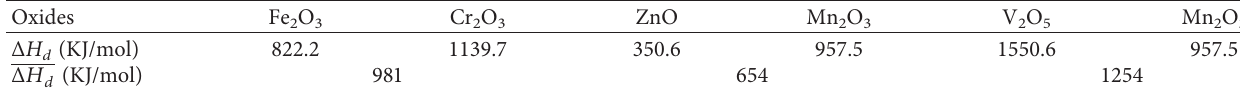
Table 5: Estimated average weighted dissociation energy.